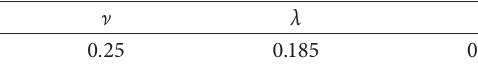
Table 1: Physical parameters of soil samples.